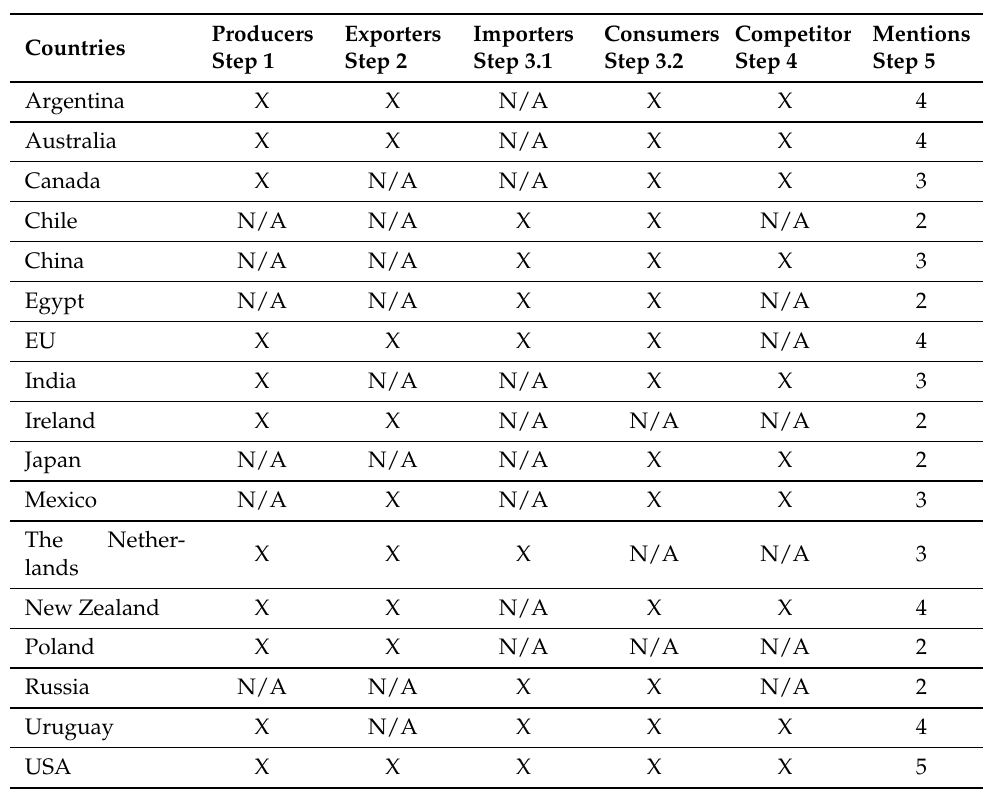
Table 4. Criteria comparison of all